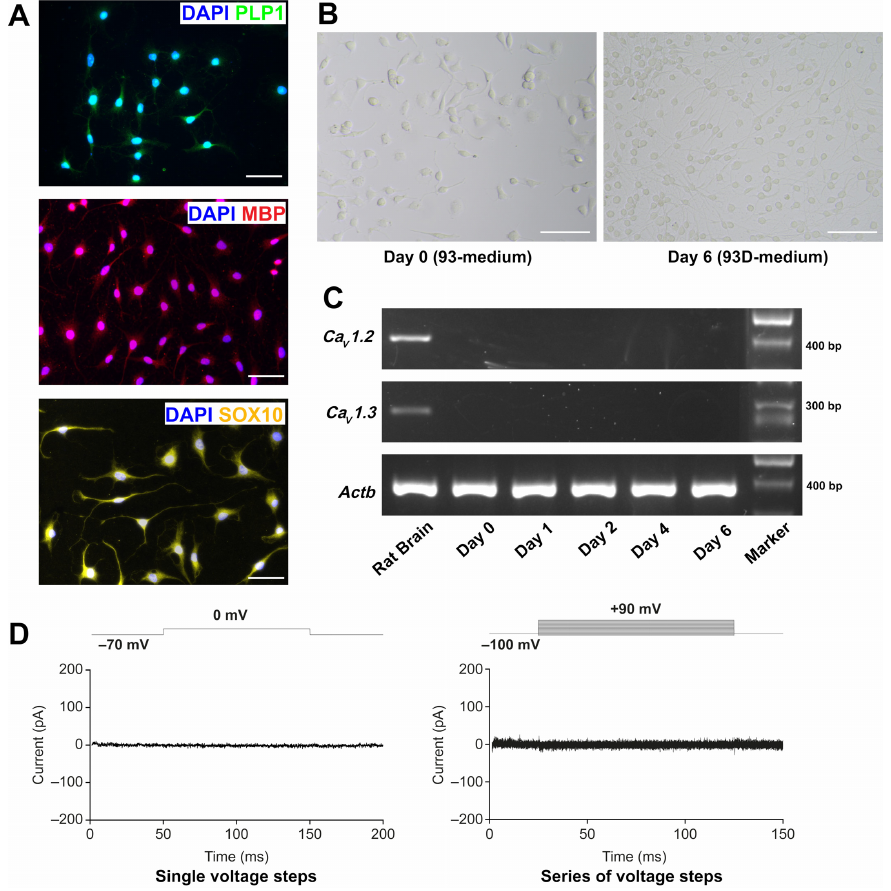
Figure 1. Characterisation of the OLN-93 cell line. ( A ) Immunofluorescence images of PLP1/DAPI, MBP/DAPI, and SOX10/DAPI staining of OLN-93 cells grown under normal FBS (10%)